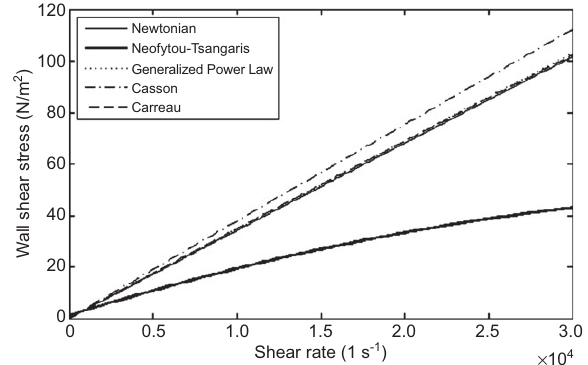
Figure 5 WSS vs. shear rate in a stenosis.